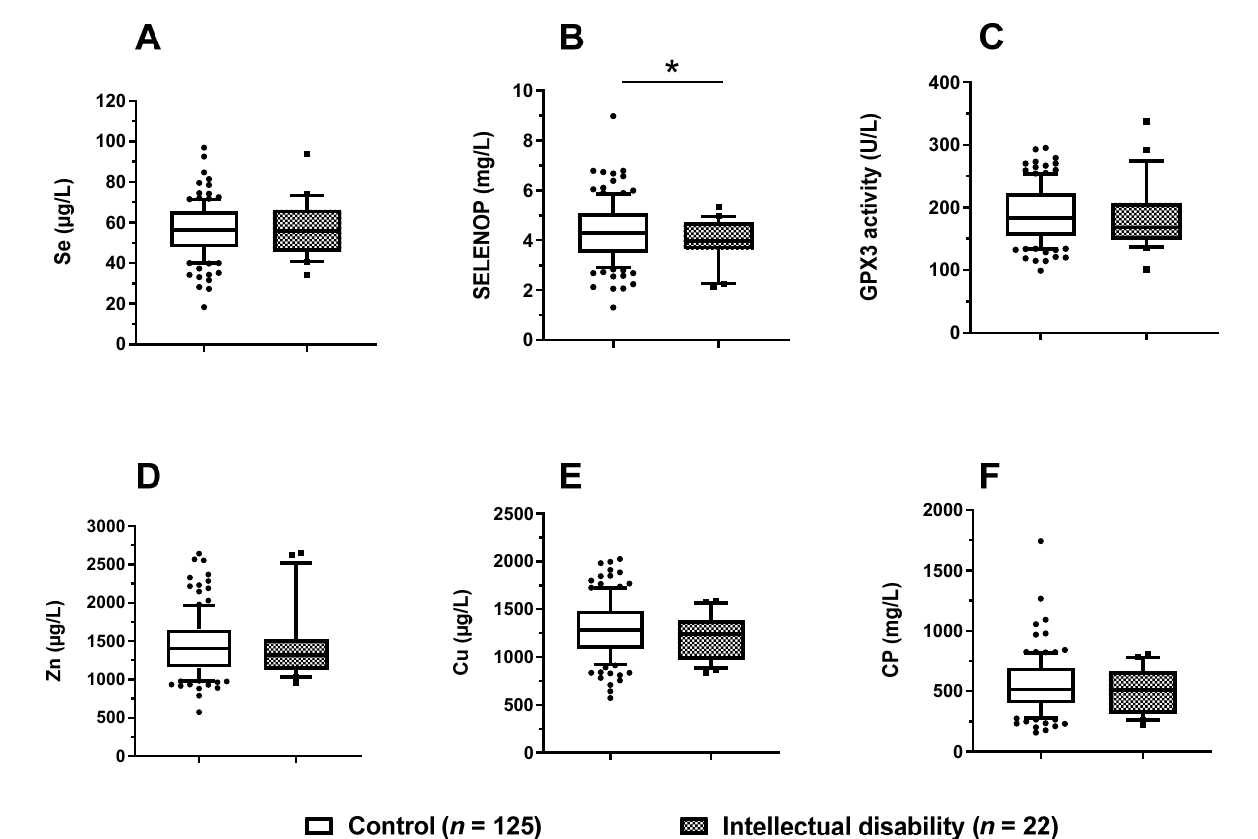
Figure 6. Serum TE status of paediatric patients with and without intellectual disability. The children with intellectual disability displayed no difference in ( A ) serum Se but ( B ) significantly lower serum SELENOP concentrations ( p = 0.016) as compared with the children without intellectual disability. No differences in serum ( C ) GPX3 activities, ( D ) serum Zn, ( E ) serum Cu, or ( F ) serum CP concentrations were noted. Data are presented as box plots (10th–90th centiles); general linear model with univariate test adjusted for age and gender was used to compare the groups. All tests were two-sided and p -values < 0.05 were considered statistically significant; * indicates p < 0.05.